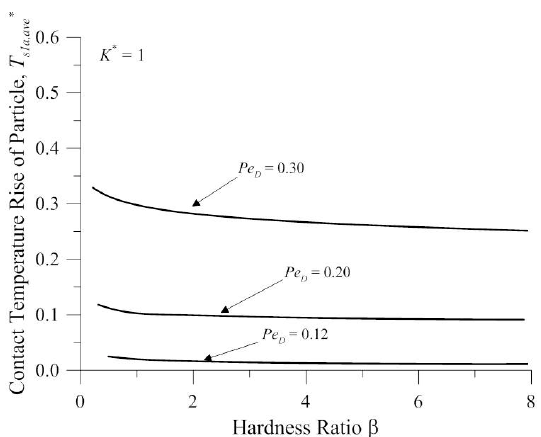
Figure 3. The contact temperature vs. the hardness ratio β at various Peclet numbers based on the particle diameter Pe D for the results from the present analysis.